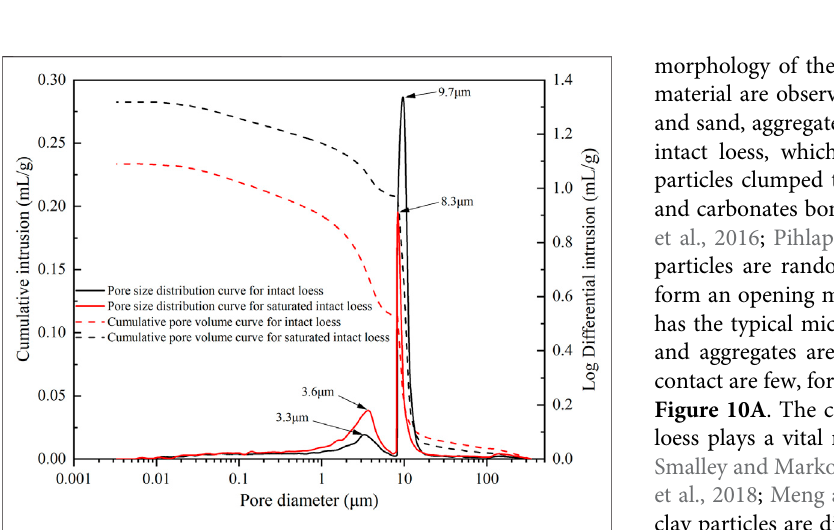
Frontiers in Earth Science |